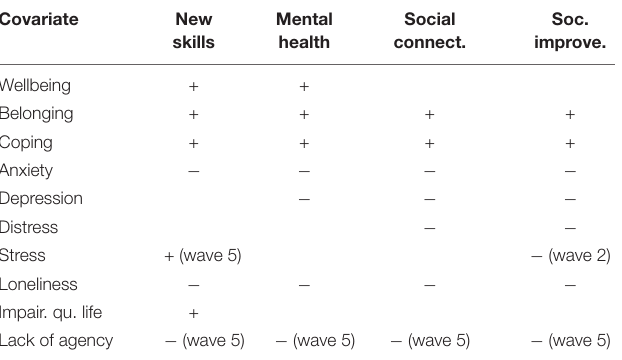
TABLE 4 | Summary of significant predictors of hope-optimism